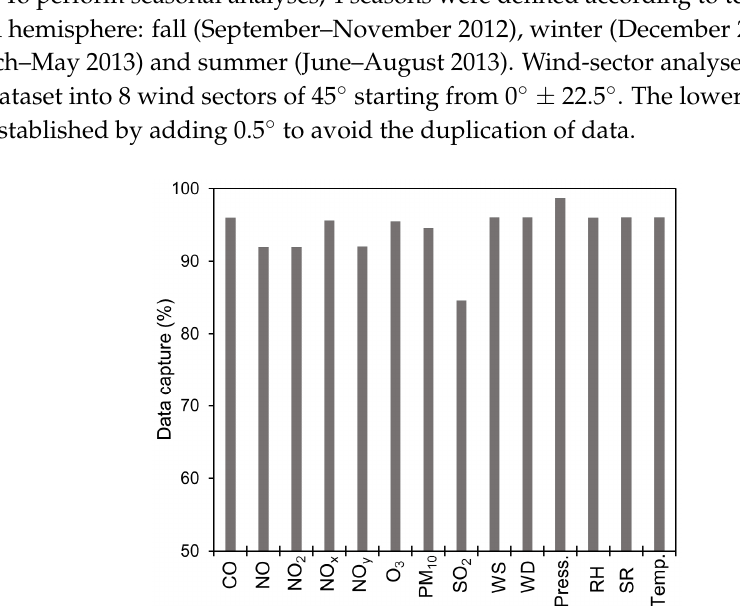
Figure 2. Data capture of 1 h averages for air pollutants and meteorological parameters recorded at the OBI site from September 2012 to August